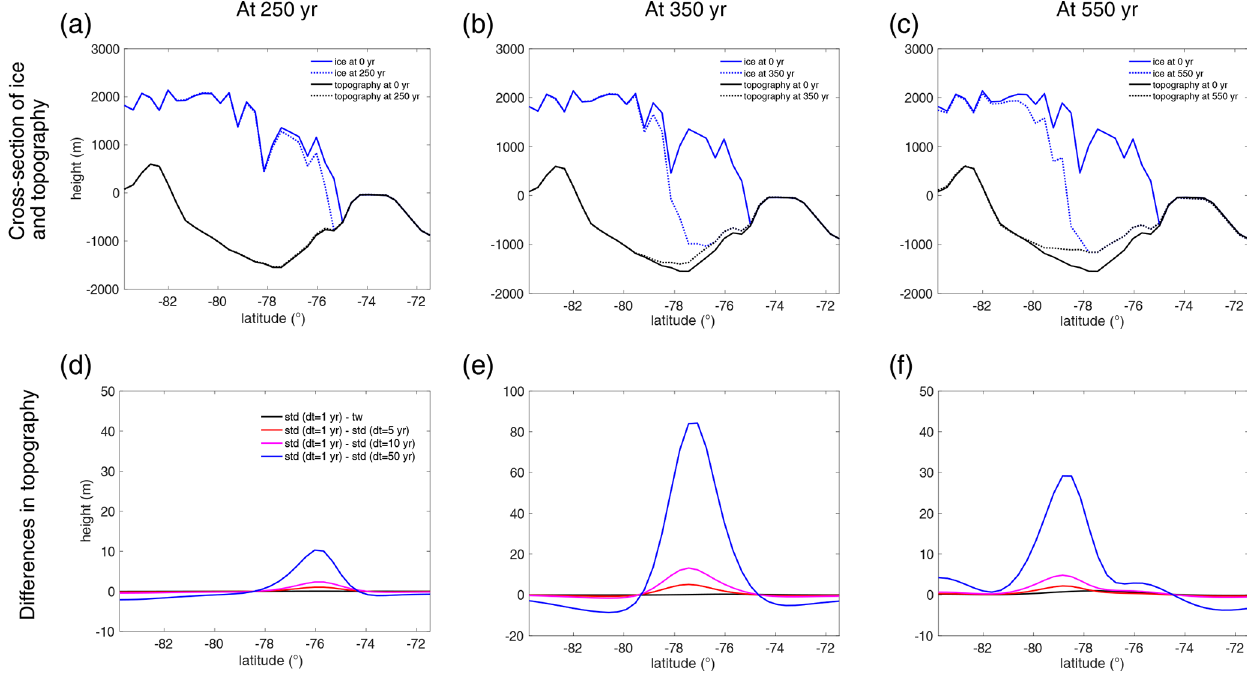
Figure 8. Elevations of the ice sheet and topography across the grounding line in the West Antarctic region (red line shown in Fig. 6g) and the sensitivity of predicted topography to temporal resolution in standard and time window simulations based on a stand-alone (uncoupled) sea-level model. (a–c) Ice surface (blue lines) and topography (black lines) predicted from the standard (std) simulation at (a) 250 years (dashed lines), (b) 350 years (dashed lines) and (c) 550 years (dashed lines) relative to the initial simulation time of 0 years (solid lines). The cross section of the grounding line is shown by a red line in Fig. 6d. (d–f) Differences in topography at (d) 250 years, (e) 350 years and (f) 550 years, between the benchmark simulation ( dt = 1 year) and the time window simulation (black lines) that incorporates dt = 1 year for the most recent 100 years and dt = 5 years for the rest of the 450 years of the simulation (i.e., black line in Fig. 7h), and between the benchmark simulation and standard simulation with dt = 5 years (red lines), dt = 10 years (magenta lines), and dt = 50 years (blue lines). Note the change in the y axis in (e)